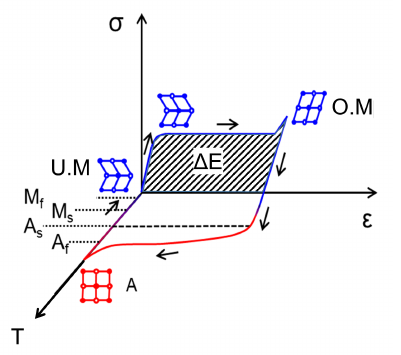
Figure 1. Illustration of phase transformation for one-way shape memory